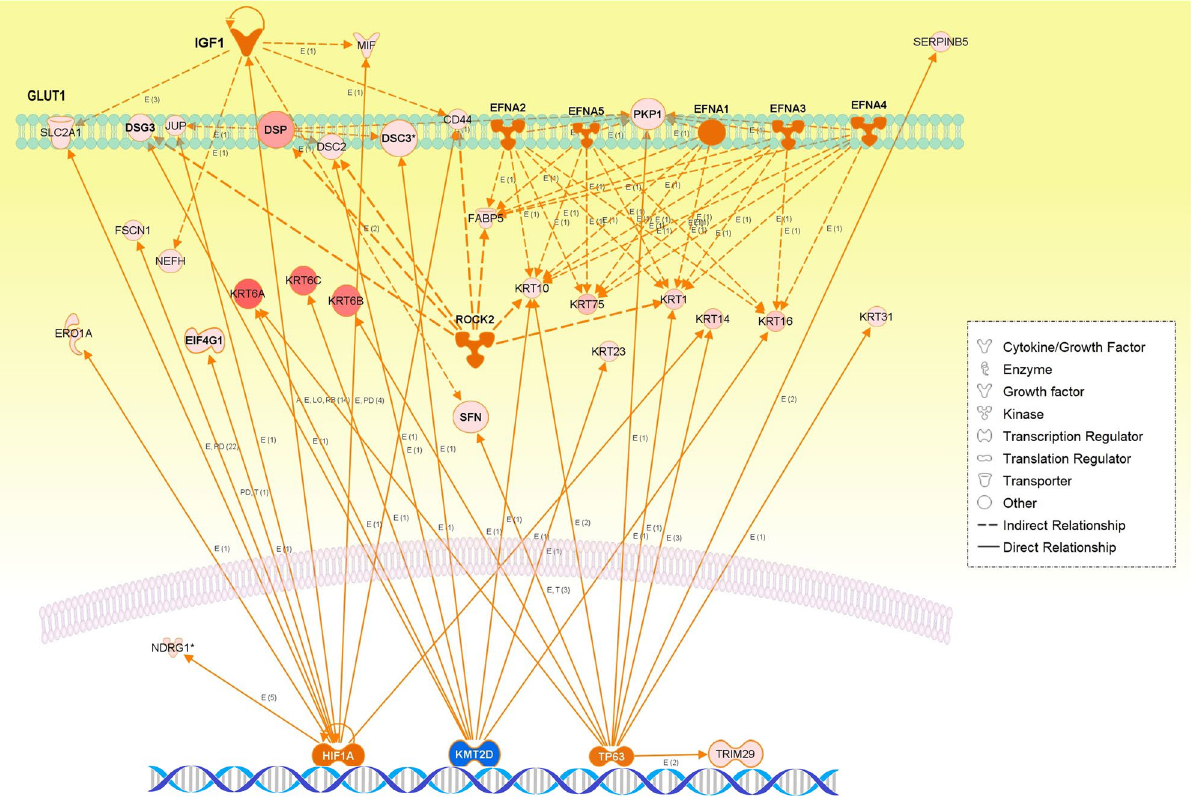
Figure 5. The integrative networks of representative master and participating regulators predicted for the WM26